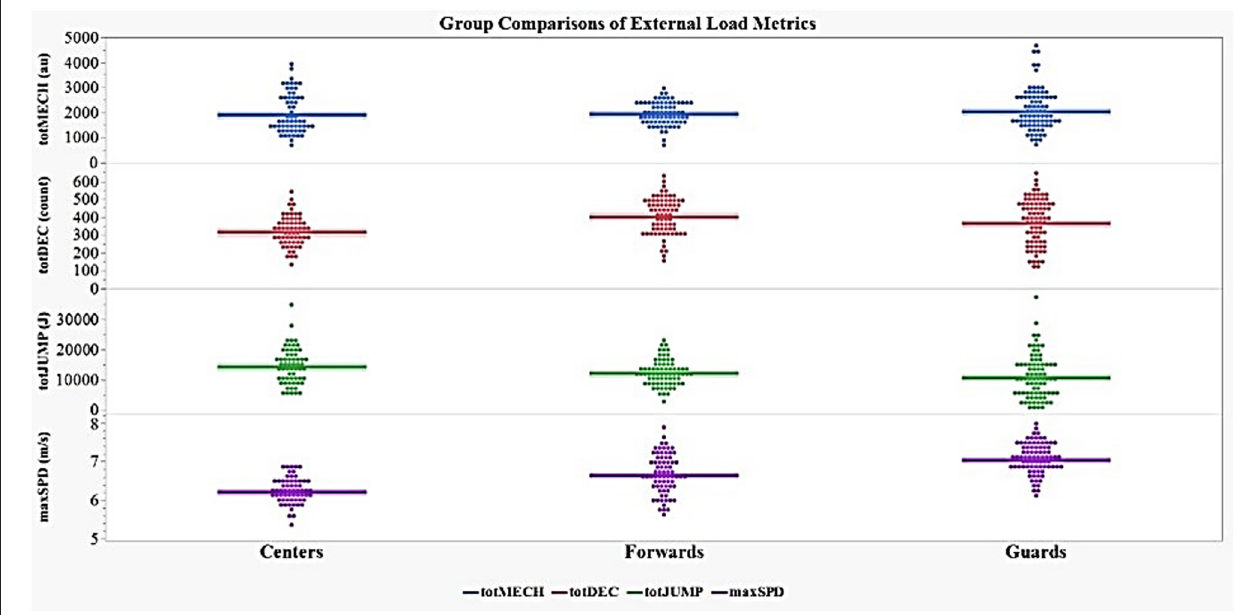
FIGURE 4 | Group comparisons of external load variables by player position. maxSPD, maximum speed; totDEC, total decelerations; totJUMP, total jump load. enhancements that are based on quantitative insights.